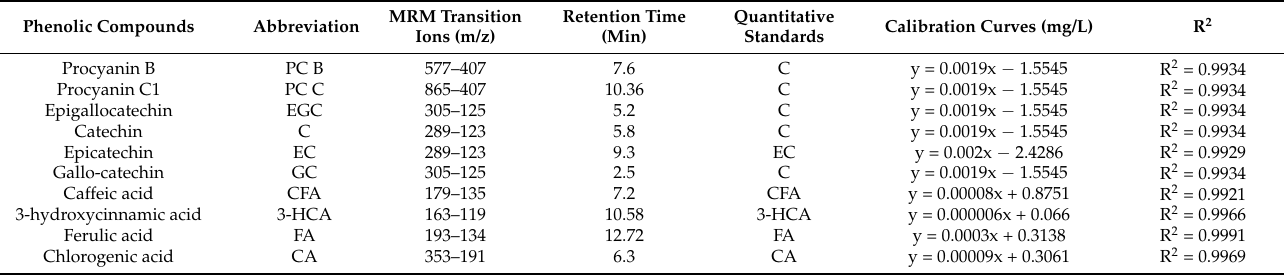
Table 1. Abbreviation, MRM information, and calibration curves of phenolic